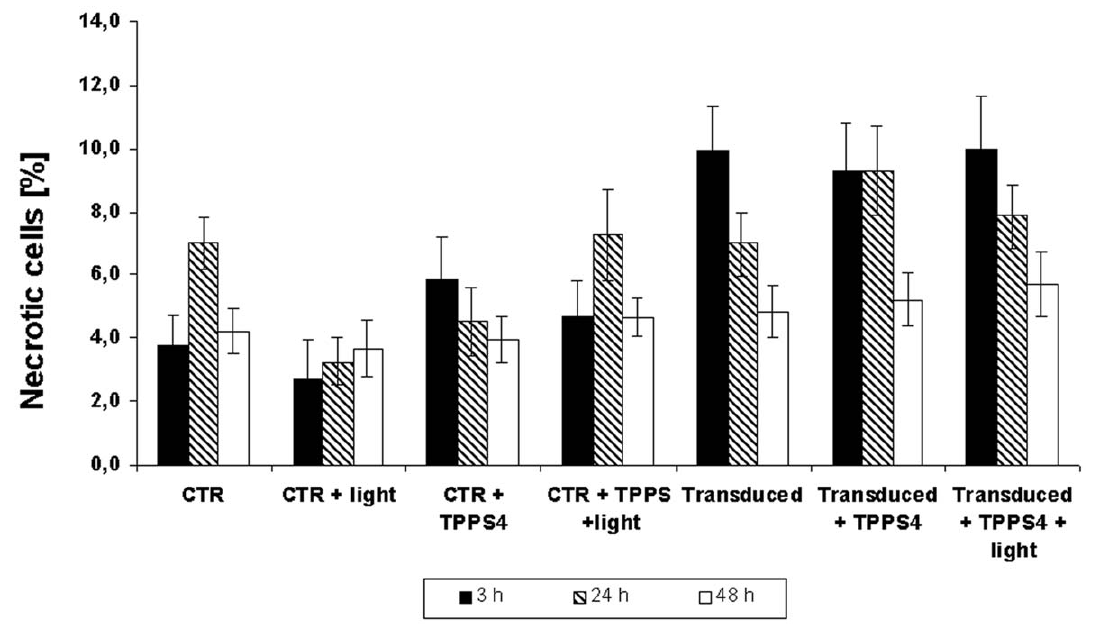
Figure 4. Cytotoxicity of the PCI treatment. To measure cytotoxicity of the PCI application sarcoma cells were stained with trypan-blue 3 h, 24 h and 48 h after various treatments. Cells exposed to light (L), TPPS 4 (PS) or with both show no striking changes in the percentage of trypanblue positive cells compared to untreated controls. Cells transduced with Proteoducin (T) show an initial increase of dead cells. Additional treatments with the TPPS 4 photosensitizer or complete PCI did not change the percentage of trypanblue positive cells. Each experiment was performed 3 times (n=300 2 900). The error bars represent the 95% confidence intervals of the means.